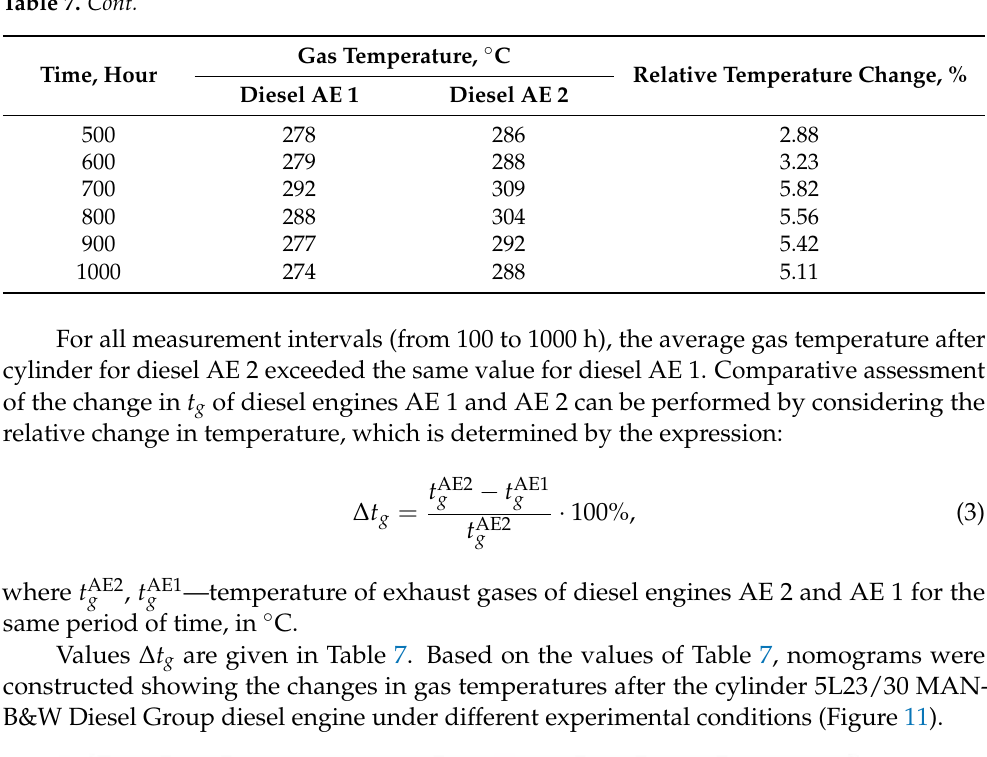
Table 7. Change in the temperature of after-cylinder gases in diesel engine 5L23/30 MAN-B&W Diesel Group under different experimental conditions.